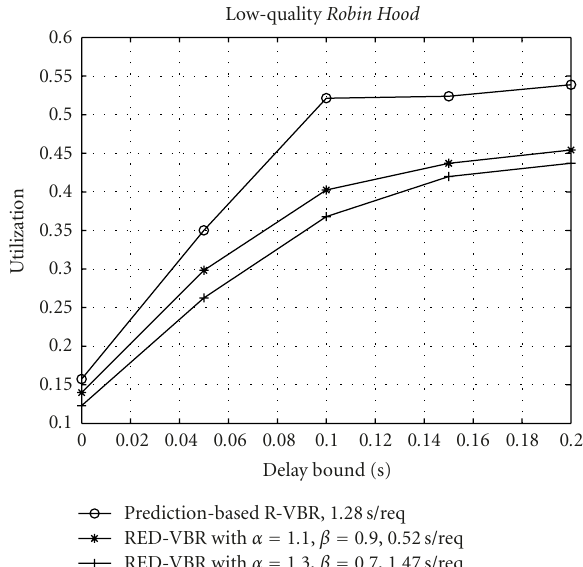
Figure 3: Comparison between online prediction-based R-VBR scheme and RED-VBR scheme for Robin Hood .